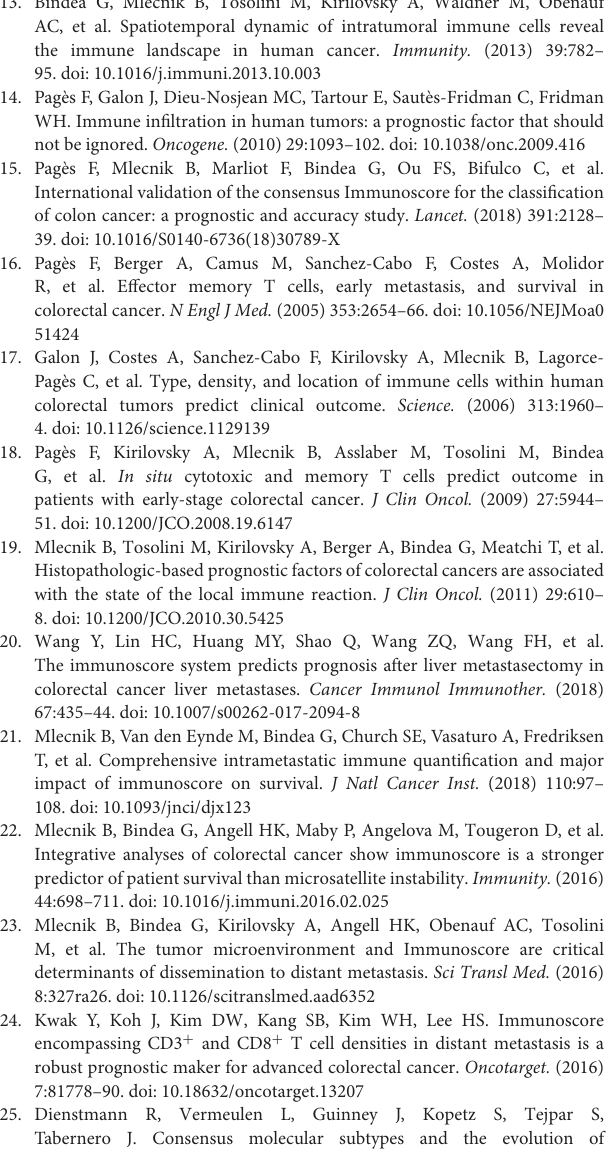
Tabernero J. Consensus molecular subtypes and the evolution